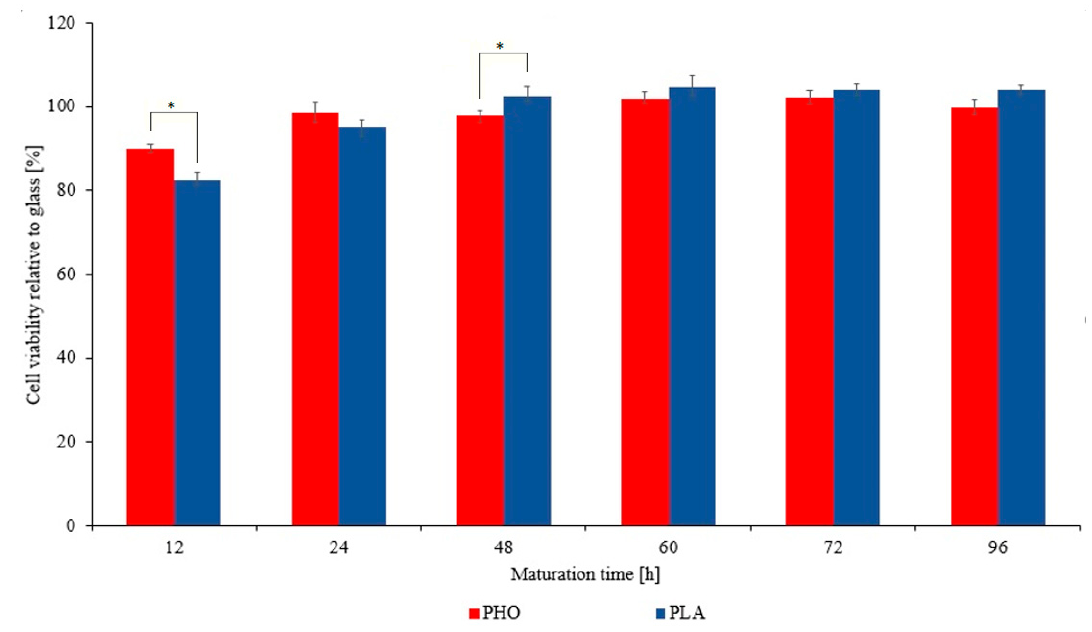
Figure 1. Comparison of PHO and PLA cytotoxic activity relative to glass. Data for glass and PHO was taken from earlier study [21]. The horizontal axis shows the time elapsed since pouring the polymer. After 24 h the atrophy of the influence of the evaporating solvent on cell viability can be seen. Results statistical significance: * p < 0.05